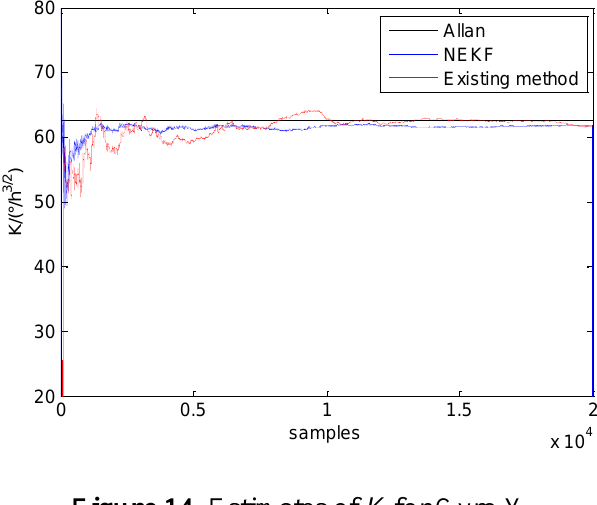
Figure 14. Estimates of K for Gyro Y.